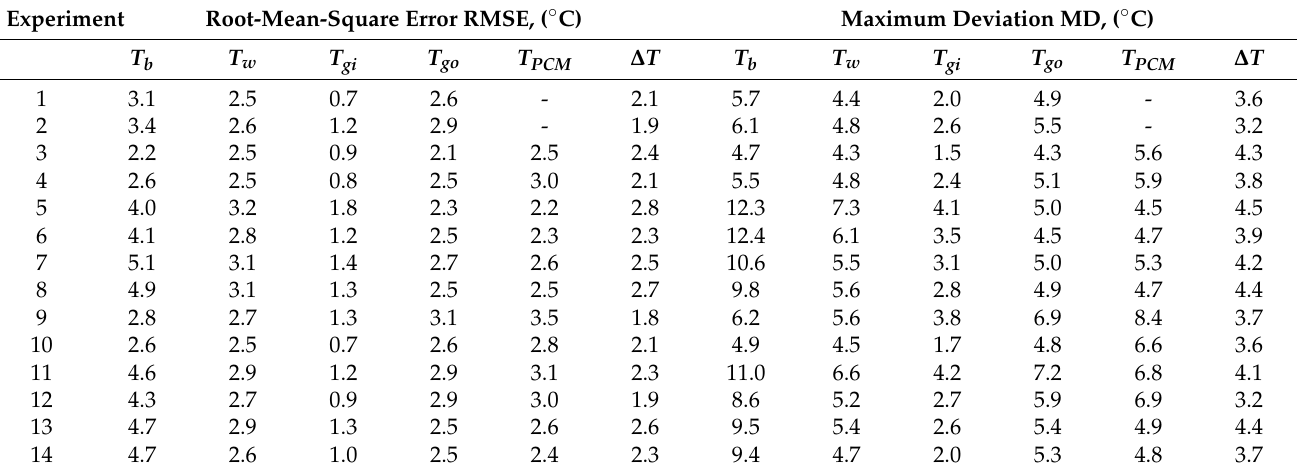
Figure 7. Comparison of water temperature obtained in experiments and simulations: ( a ) No PCM and PCM 1 — experimental results; ( b ) No PCM and PCM 1 — simulation results; ( c ) No PCM and PCM 2 — experimental results; ( d ) No PCM and PCM 2 — simulation results. Table 6. The root-mean-square error (RMSE) and maximum deviation of temperatures.